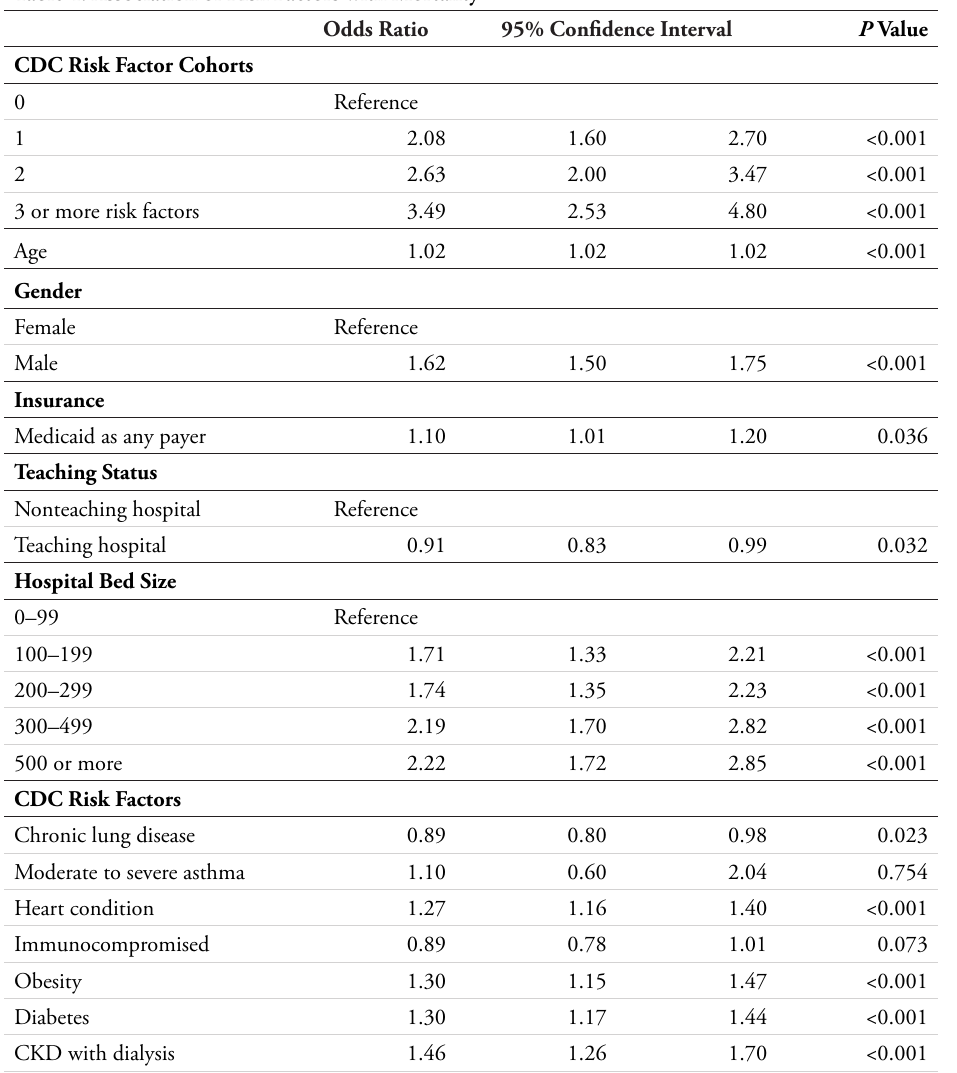
Table 4. Association of Risk Factors with